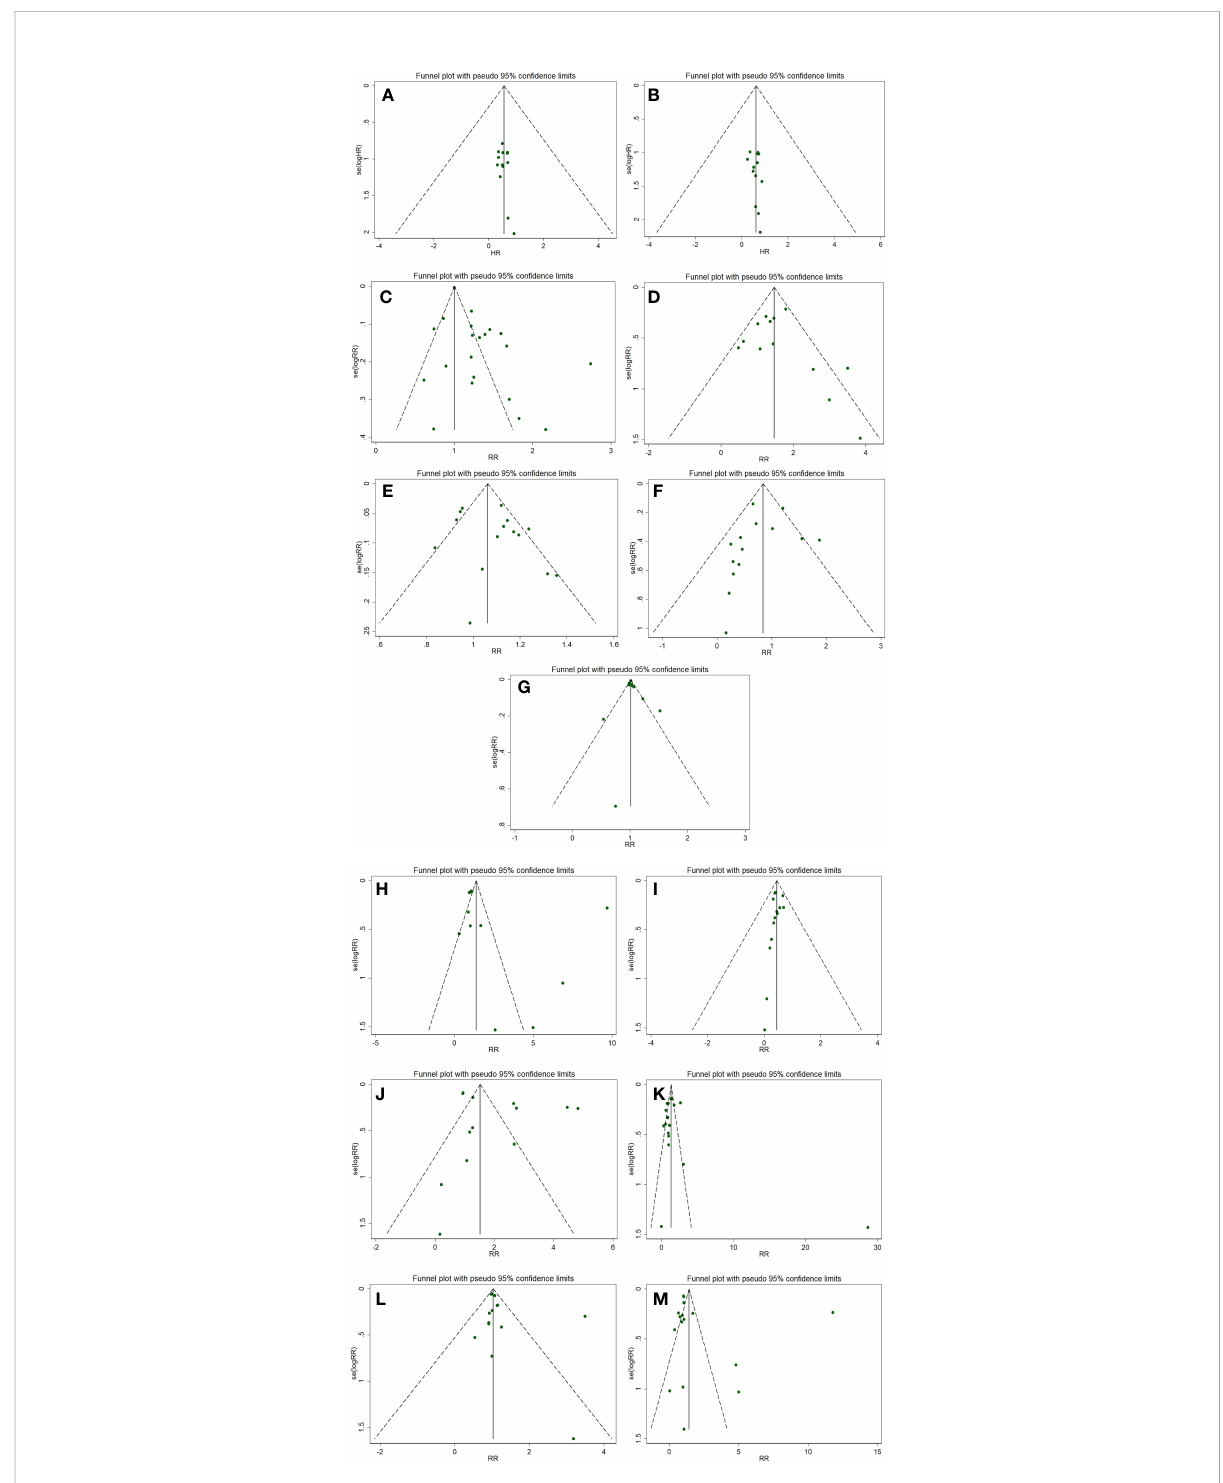
FIGURE 3 Funnel plots evaluating publication bias for following outcomes: PFS (A) , OS (B) OS, ORR (C) , CRR (D) , DCR (E) , PD (F) , total adverse events (G) , anemia (H) , vomiting (I) , diarrhea (J) , neutropenia (K) , alopecia (L) , and fatigue (M)